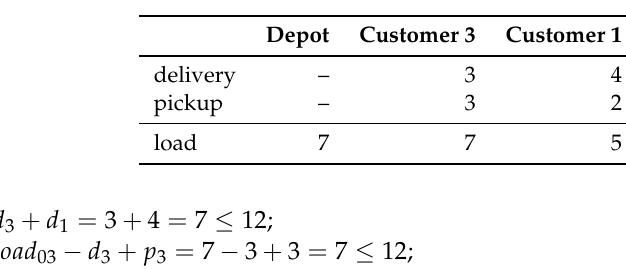
Table 2. Vehicle load of the tentative route 0 − 3 − 1 − 0.